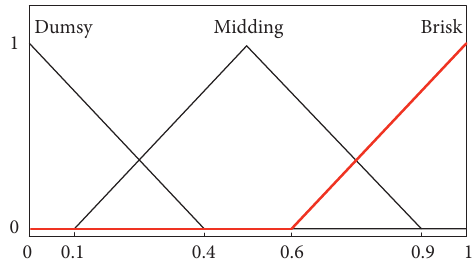
Figure 23: FV membership functions for LV l r : “AMR dynamics”.